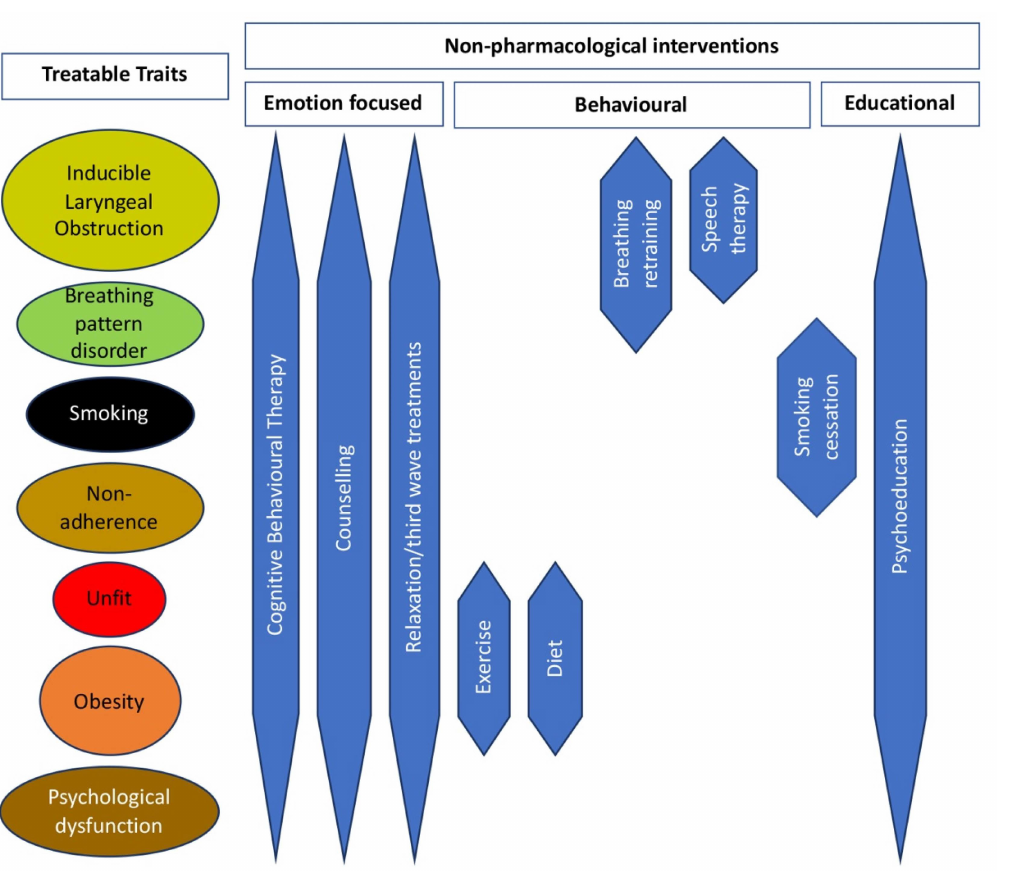
Figure 4. Non-pharmacological treatment approaches for the treatable traits of asthma and “Difficult Breathing